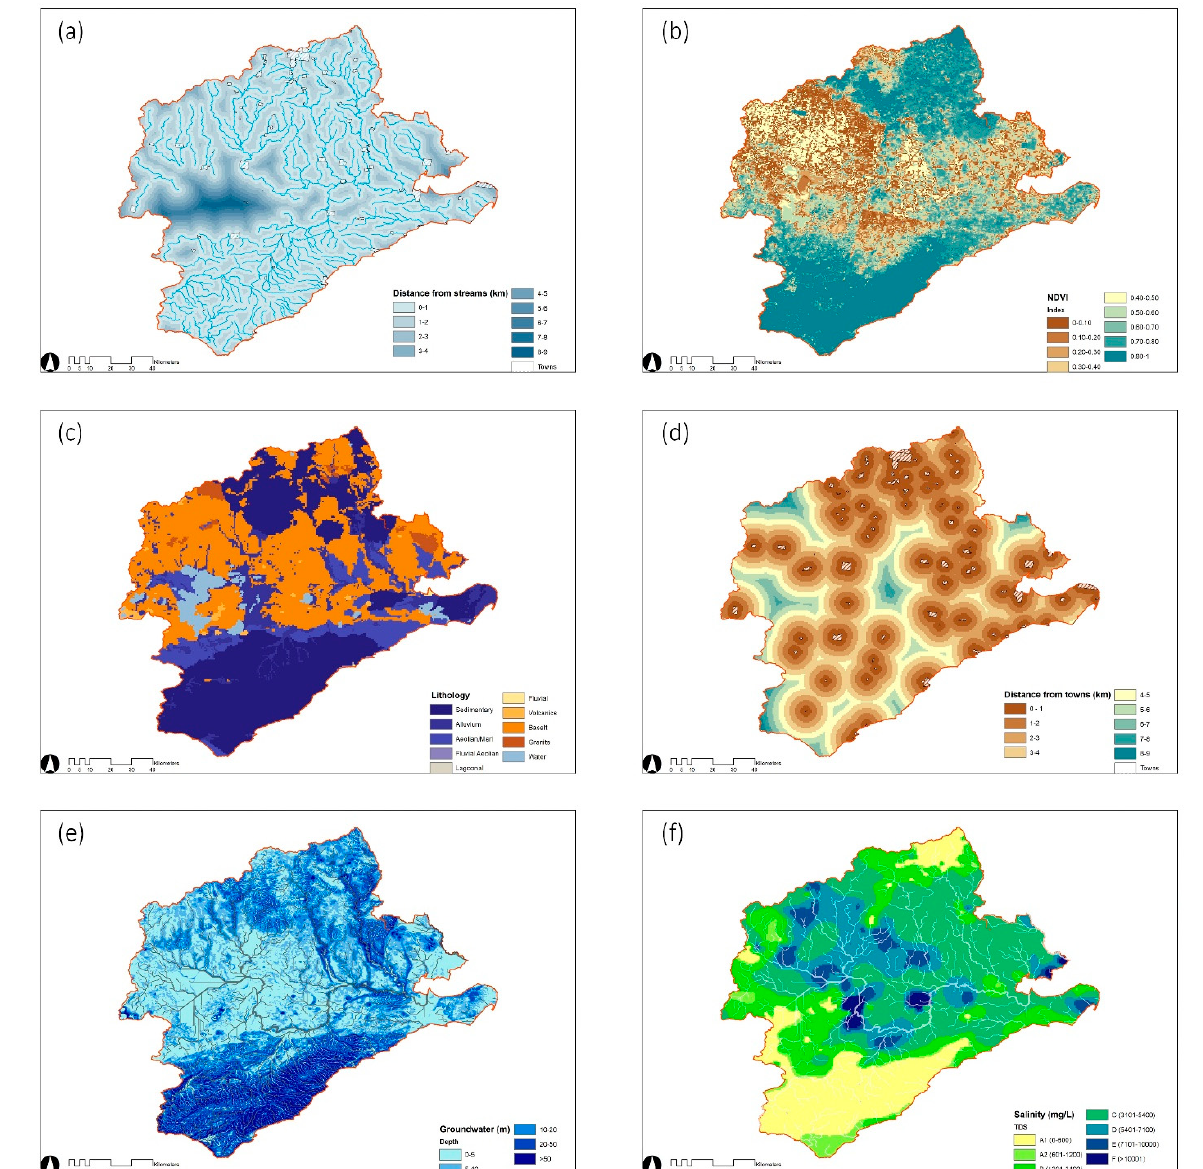
Figure 3. ( a – f ) Essential parameters: ( a ) distance from streams; ( b ) NDVI; ( c ) lithology; ( d ) distance from towns; ( e ) groundwater; ( f ) salinity. Table 2. Reclassified layers and their preference value.